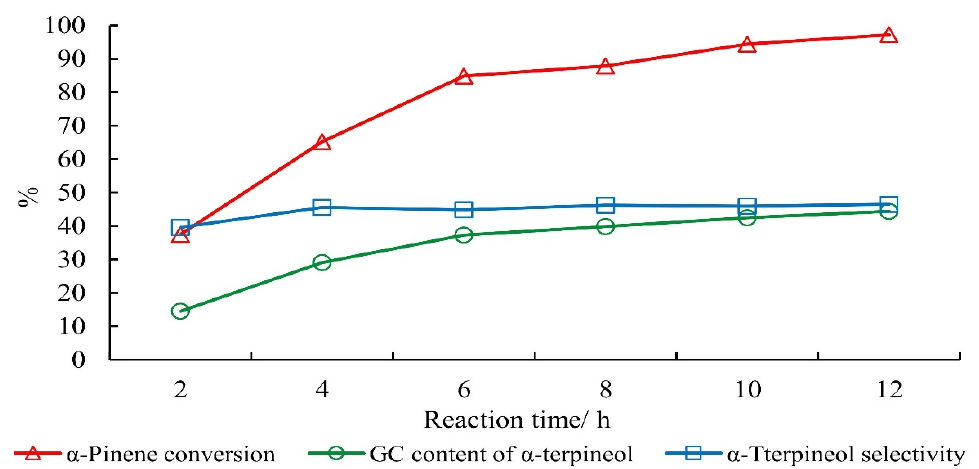
Figure 10. Effect of reaction temperature on the hydration of alpha-pinene. Note: The mass ratio of alpha-pinene, water, acetic acid, citric acid and phosphoric acid was 1:1:2.0.5:1:0.05 for 15 h.